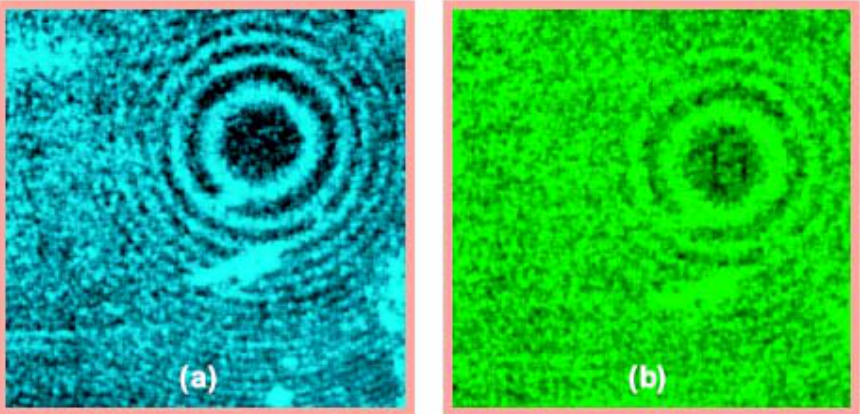
Figure 4. Magnified images of the rings for ( a ) 488-nm and ( b ) 515-nm laser illumination. In both cases, no wire is placed in the